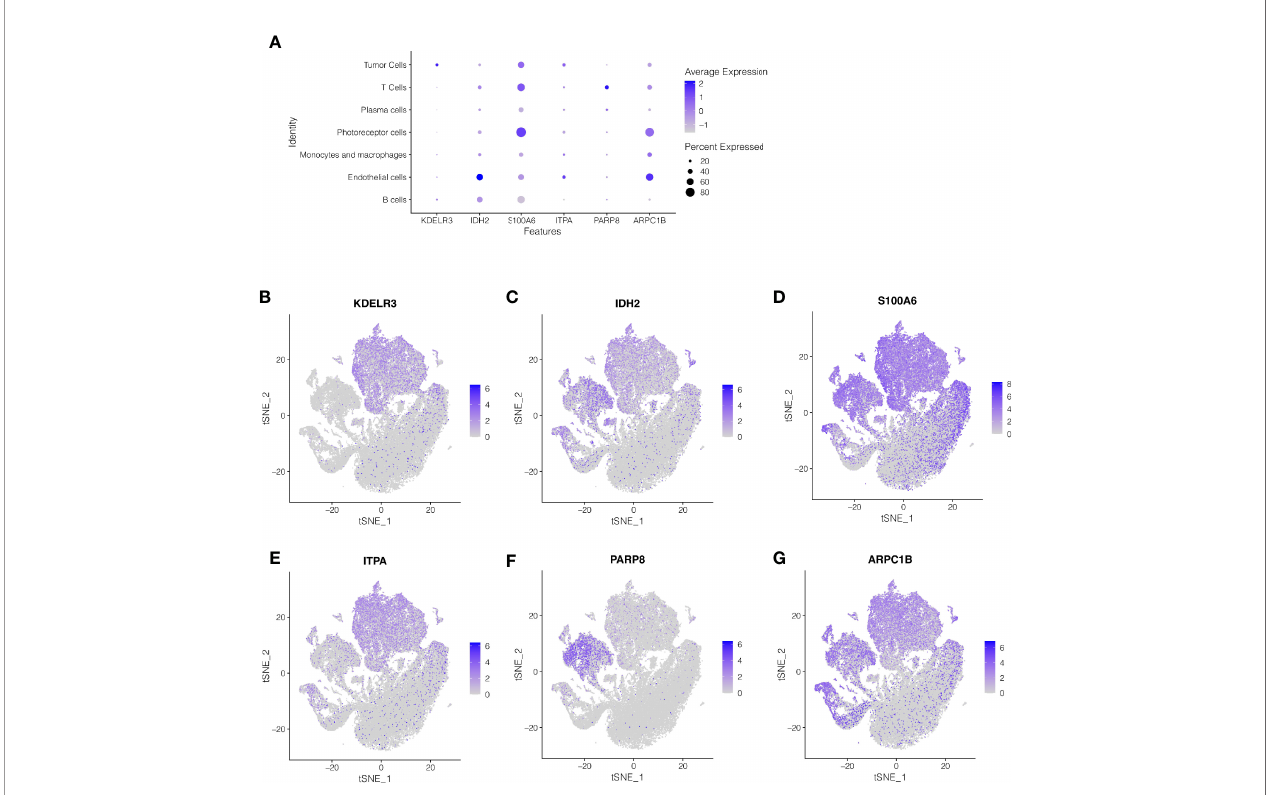
FIGURE 5 | Single-cell sequencing analysis to explore the cell localization of 6 modeling genes. (A – G) KDELR3 was mainly expressed in tumor cells, IDH2 was mainly expressed in endothelial cells, S100A6 was mainly expressed in photoreceptor cells, ITPA was mainly expressed in endothelial cells and tumor cells, PARP8 was mainly expressed in T cells, and APRC1B was mainly expressed in endothelial